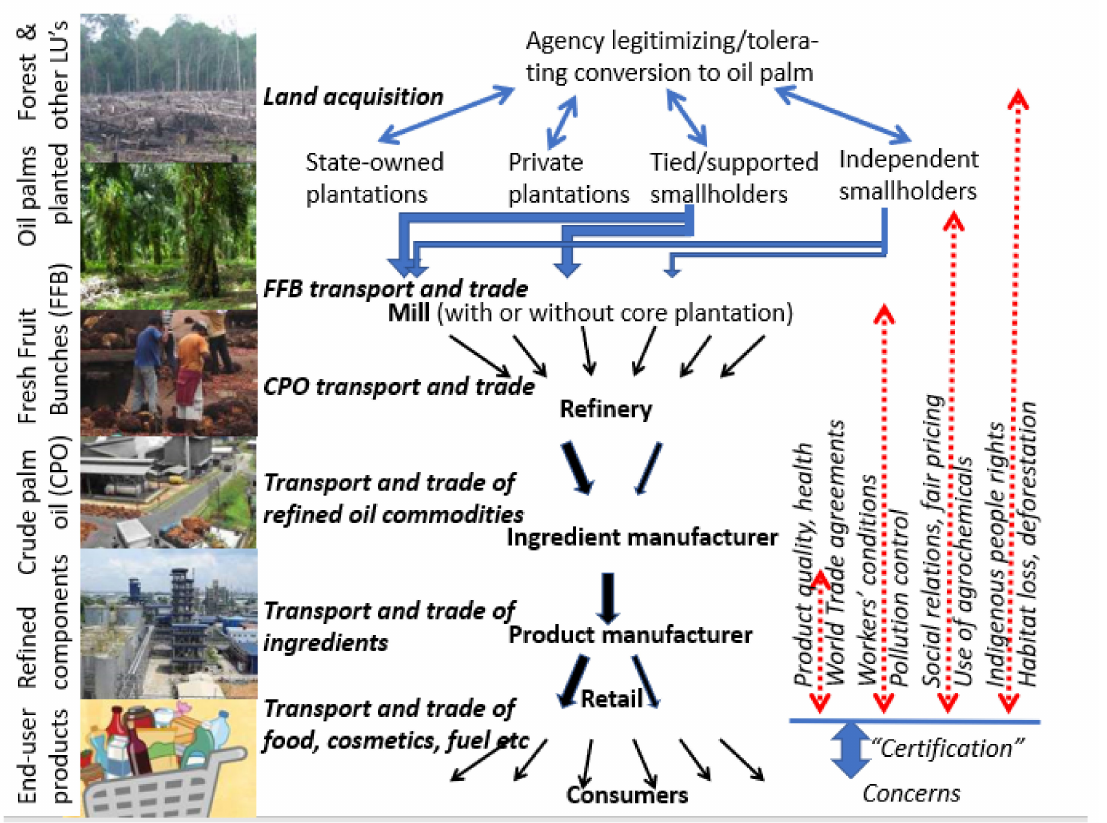
Figure 7. Schematic structure of the oil palm value chain